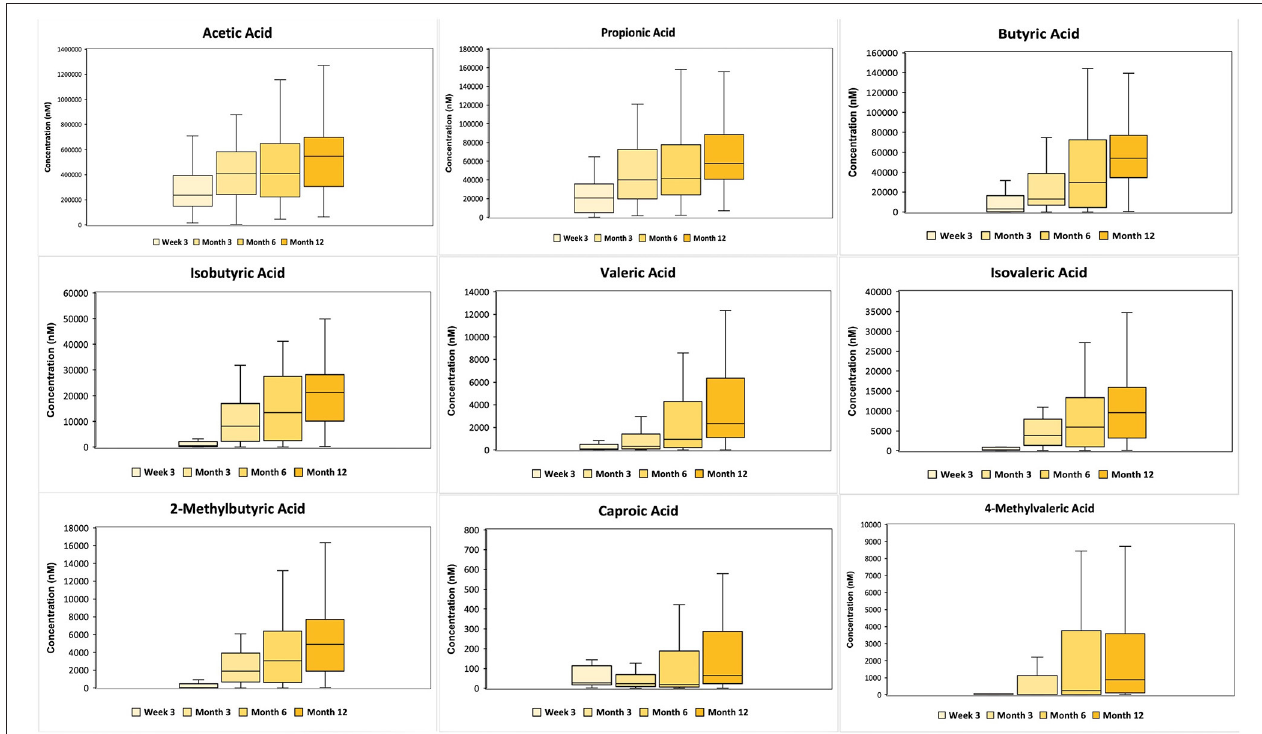
FIGURE 2 | 10th to 90th percentile SCFA concentration (in nanomolar) of 6 major SCFAs (acetic, propionic, butyric, isobutyric, isovaleric and caproic acid) and 3 minor SCFAs (valeric, 2-methylbutyric and 4-methylvaleric acid) across 3 weeks, 3, 6 and 12 months, where the middle refers to the median value. The major and minor SCFAs are split according to their concentrations. The concentration of all SCFA concentration, except caproic and 4-methylvaleric acids, increased significantly with time ( p < 0.05).